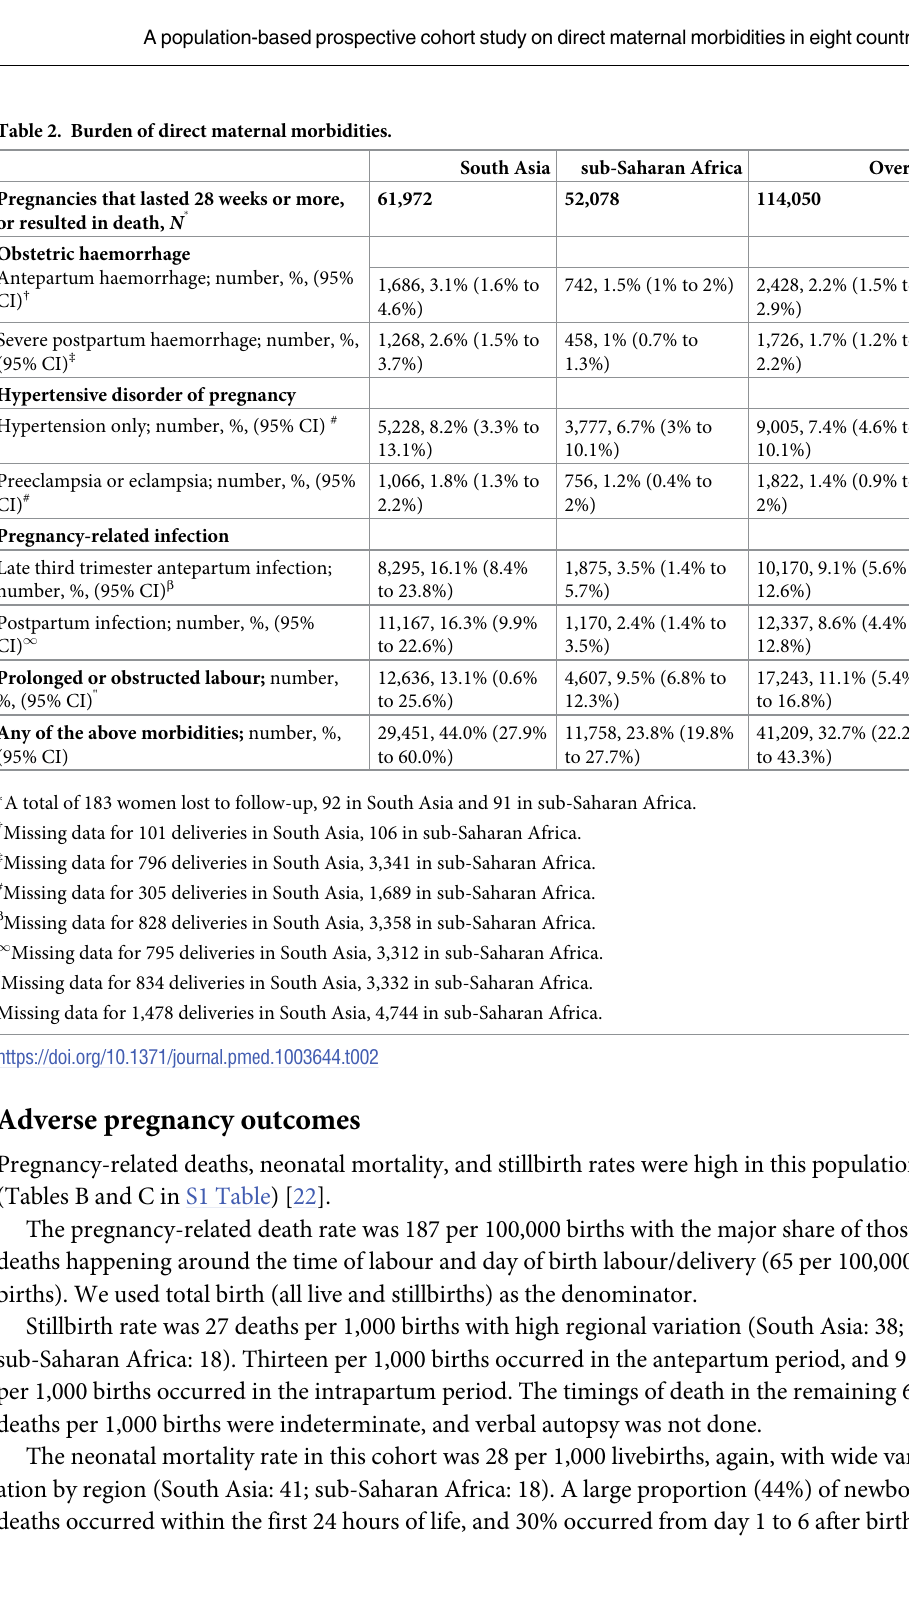
South Asia sub-Saharan Africa Overall 61,972 52,078 114,050